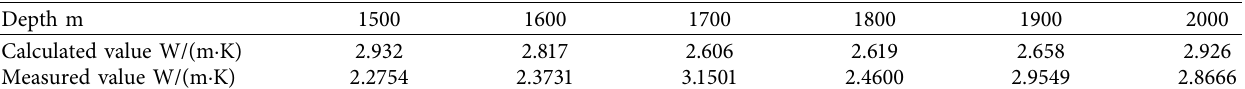
Table 4: Thermal conductivity of 1,500–2,000 m deep rock samples in the Xiling well construction area of Sanshandao gold mine.